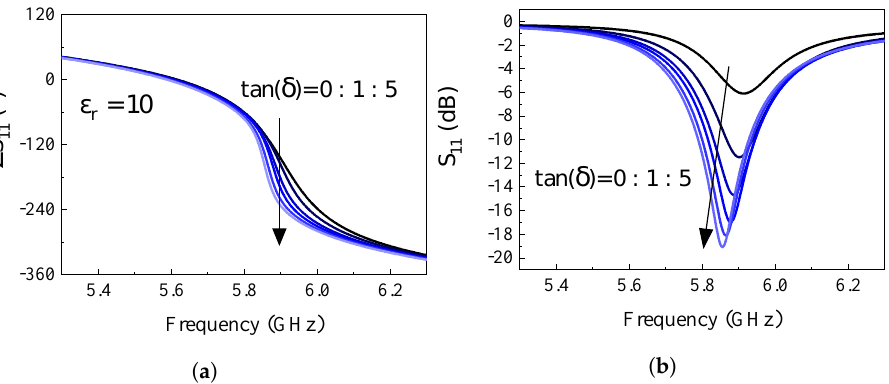
Figure 8. ( a ) Phase and ( b ) magnitude of S 11 response in simulations of various MUT properties, assuming ε r − MUT = 10, while tan( δ ) = 0:1:5.